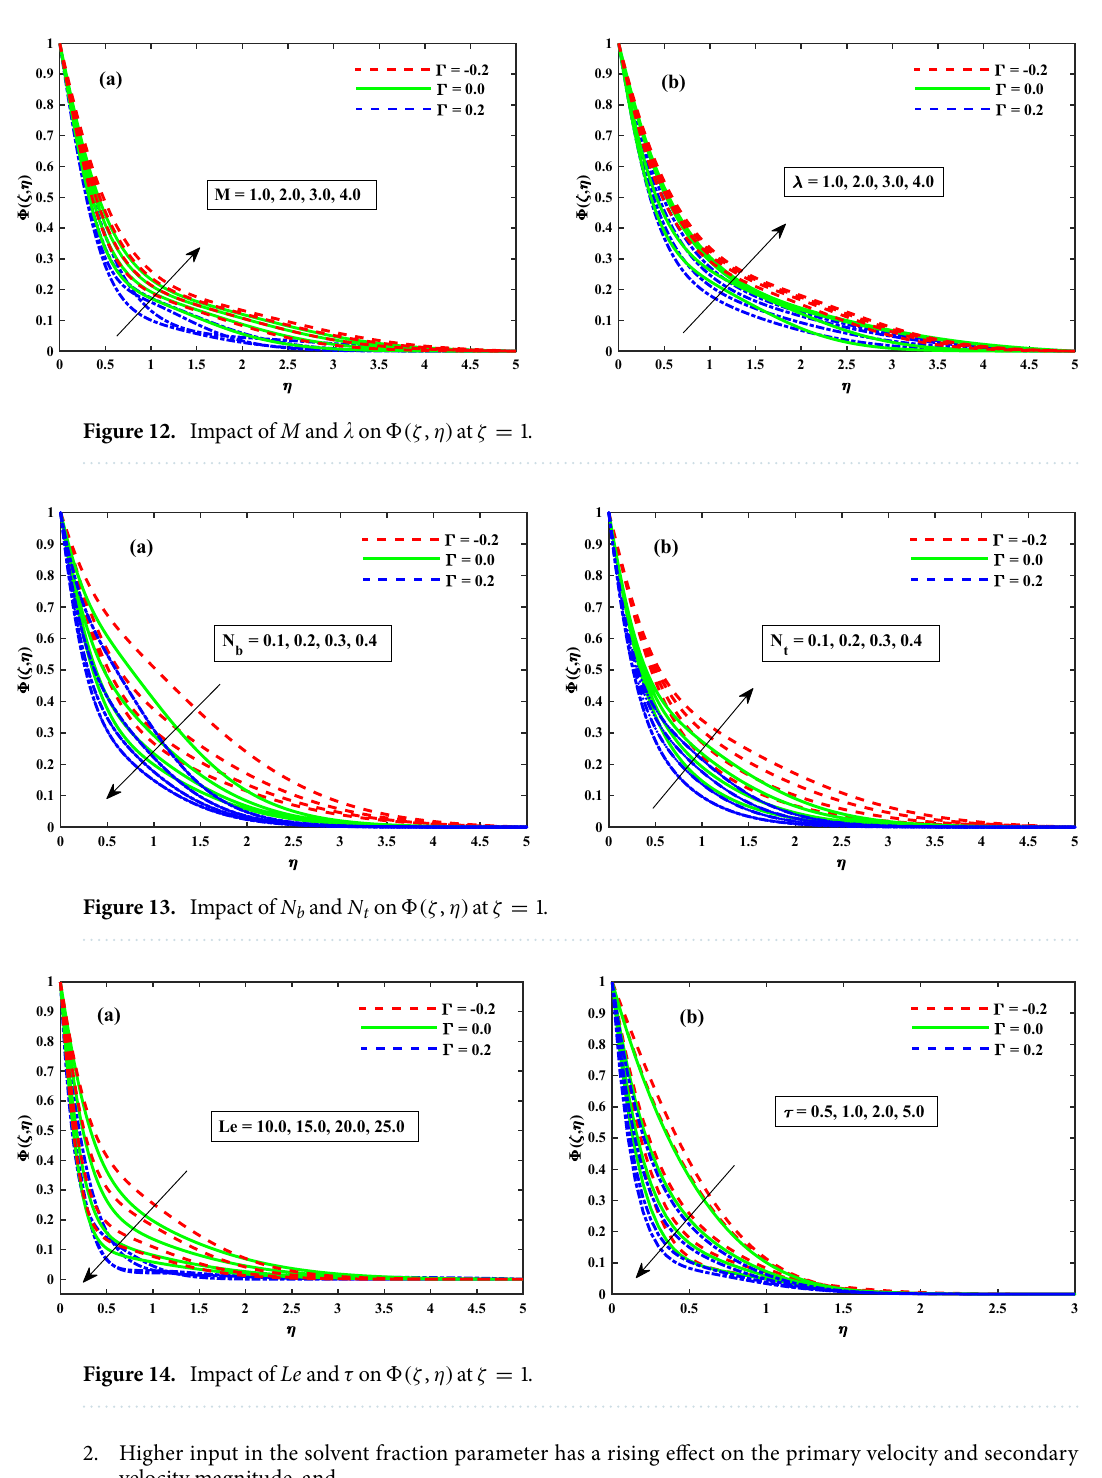
Figure 14. Impact of Le and τ on �(ζ , η) at ζ